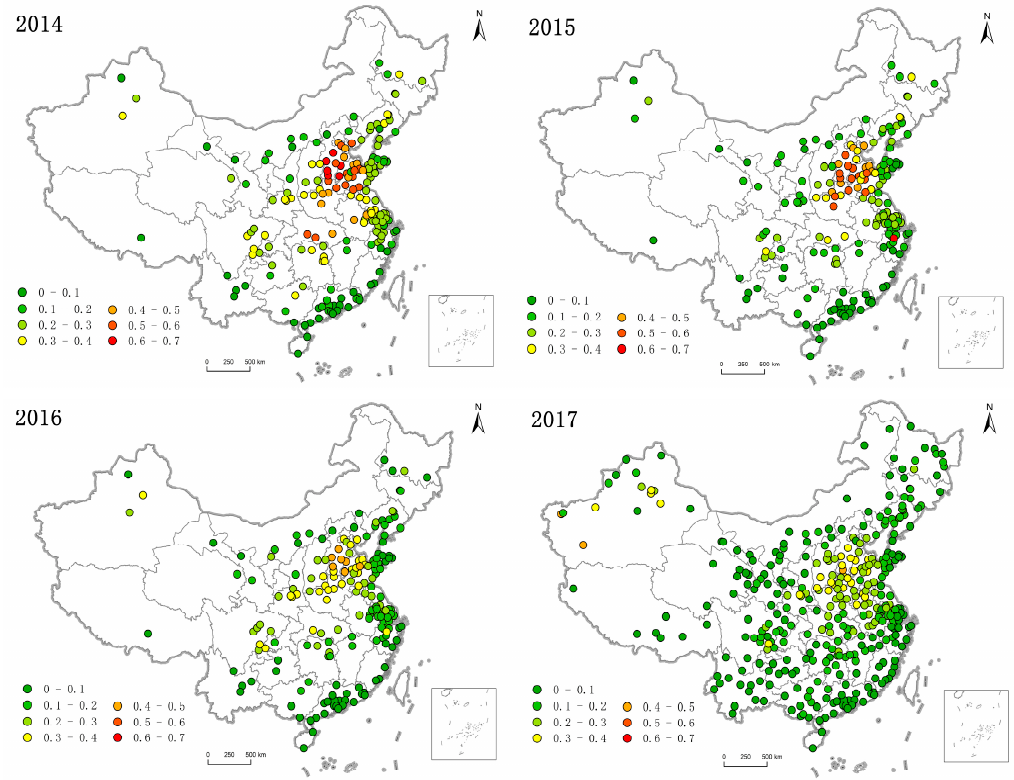
Figure 5. Proportion of days when daily average PM 2.5 concentration exceeds the standard in 2014–2017.